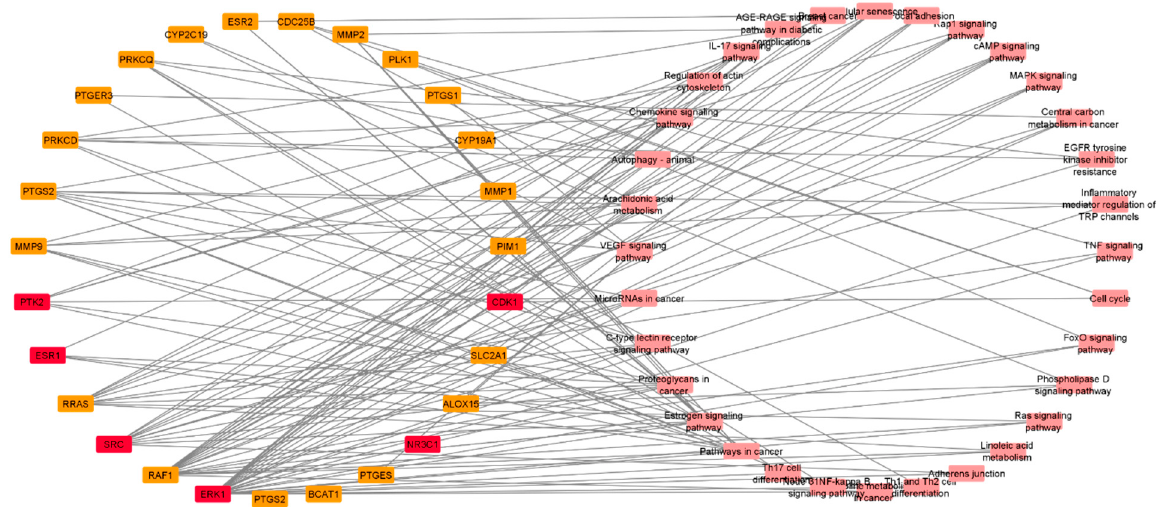
Figure 13. Protein-pathway network. This network reveals the most important genes or proteins in the enriched KEGG pathways. Targets in red squares were identified as highly interacting proteins (i.e., hub proteins) in the BC PPI network.